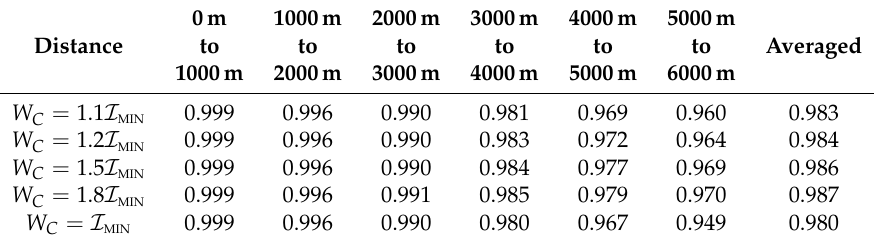
Table 5. PRP results according to distance between the LoRa GW and each ED.